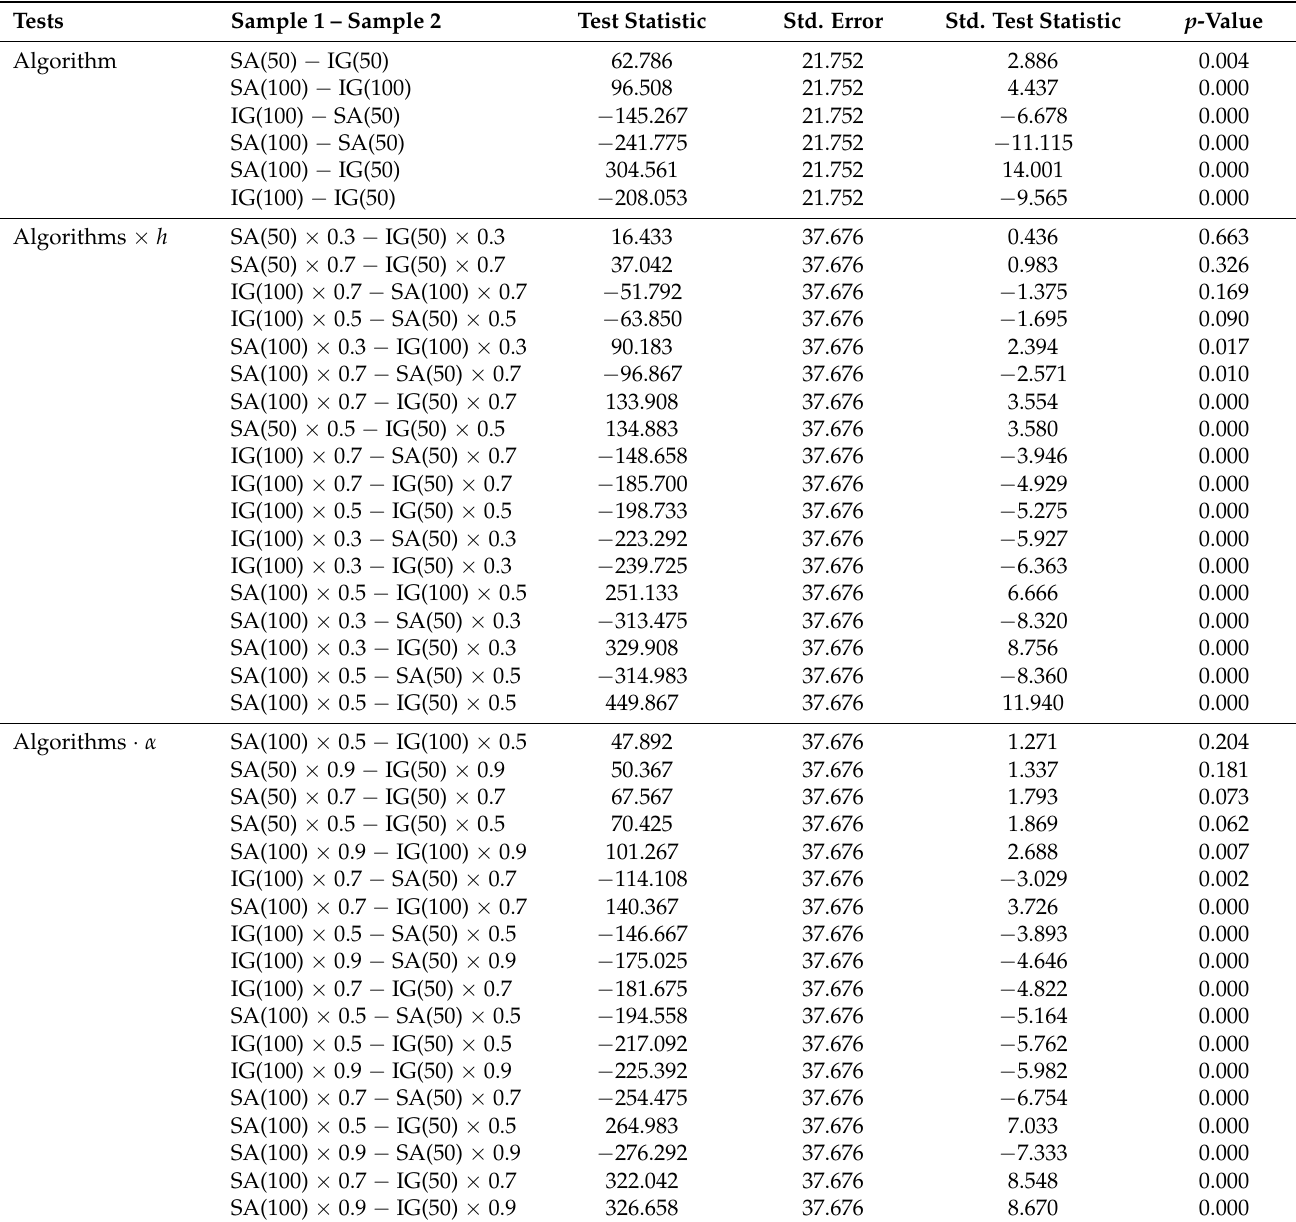
Table 6. Pairwise comparisons from Kruskal—Wallis tests for the large